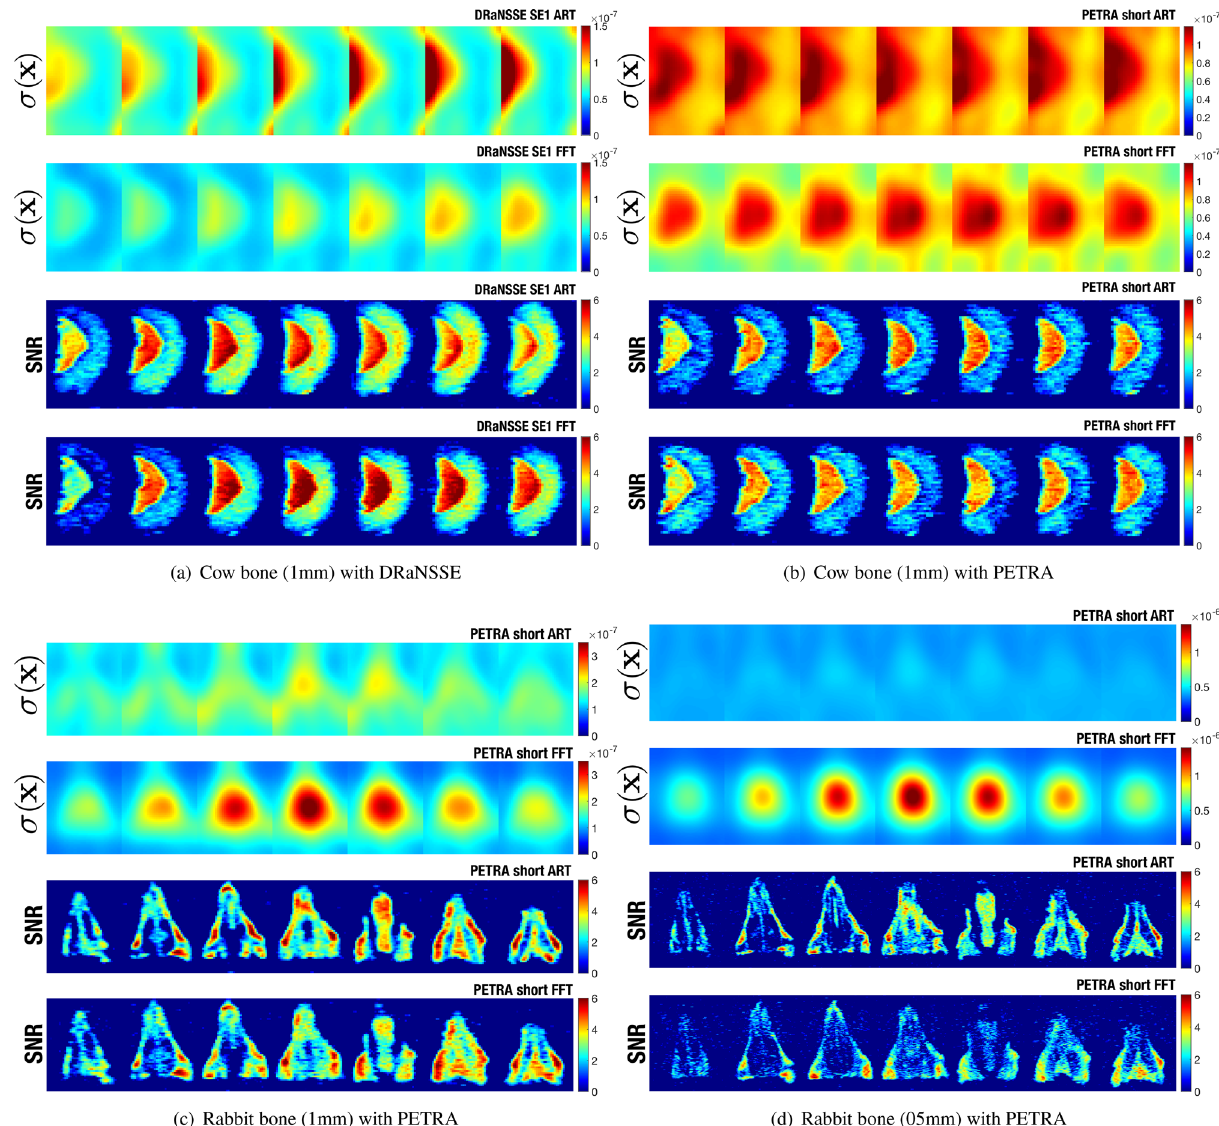
Figure 6. Noise and SNR maps for ART and Fourier transform for images VI ( a ), V ( b ), X ( c ) and I ( d